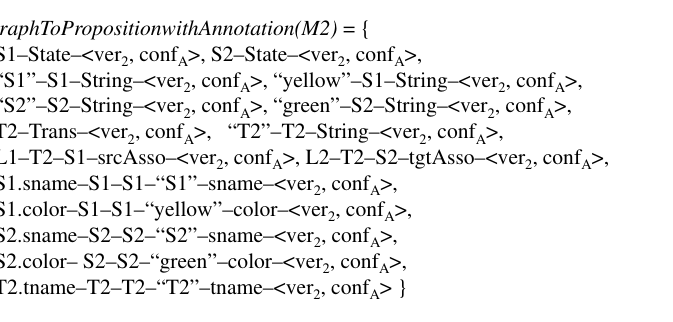
Figure 18. Representation of M2 as an E-graph.